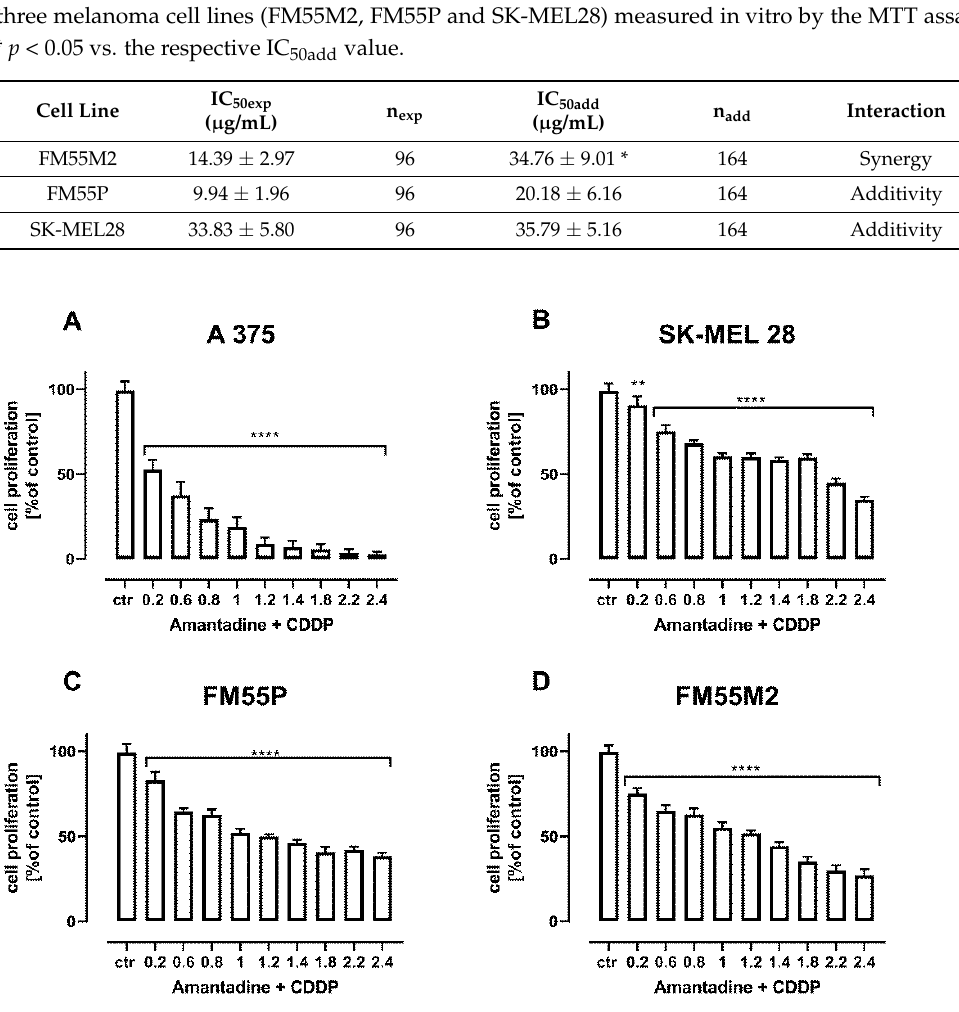
Figure 11. The effect of combination of amantadine and CDDP in fixed ratio of 1:1 on the proliferation of malignant melanoma cell lines (A375 ( A ), SK-MEL28 ( B ), FM55P ( C ) and FM55M2 ( D )) was measured by BrdU assay after 72 h. Results are presented as mean ± SEM at each concentration. (** p < 0.01; **** p < 0.0001). The values on axis X represent the multiplicity of calculated IC 50 (1.0 means half IC 50 of amantadine + half IC 50 of CDDP).